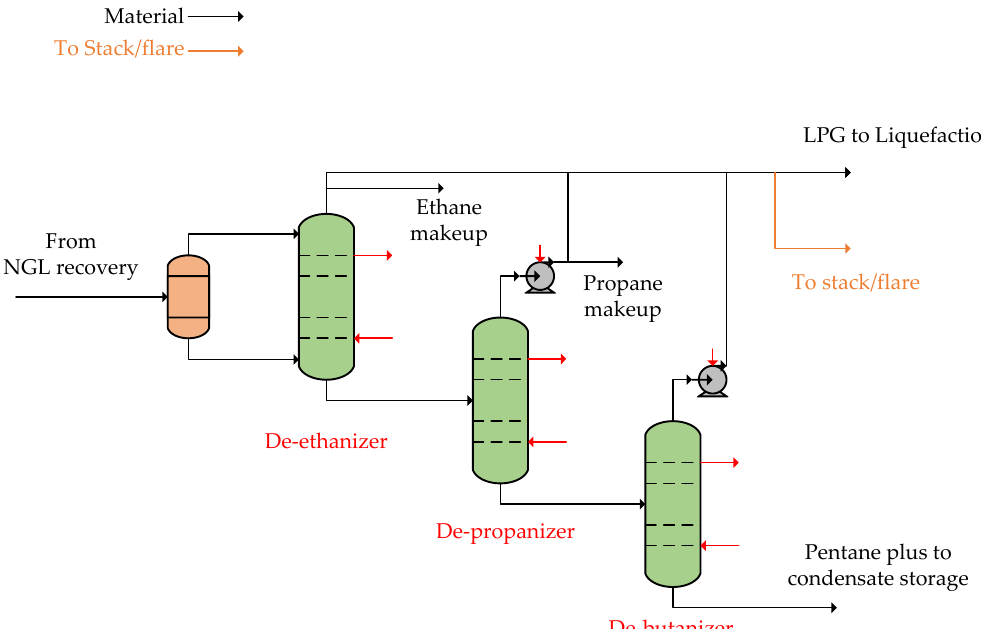
Table 10. Fractionation unit conditions and specifications.